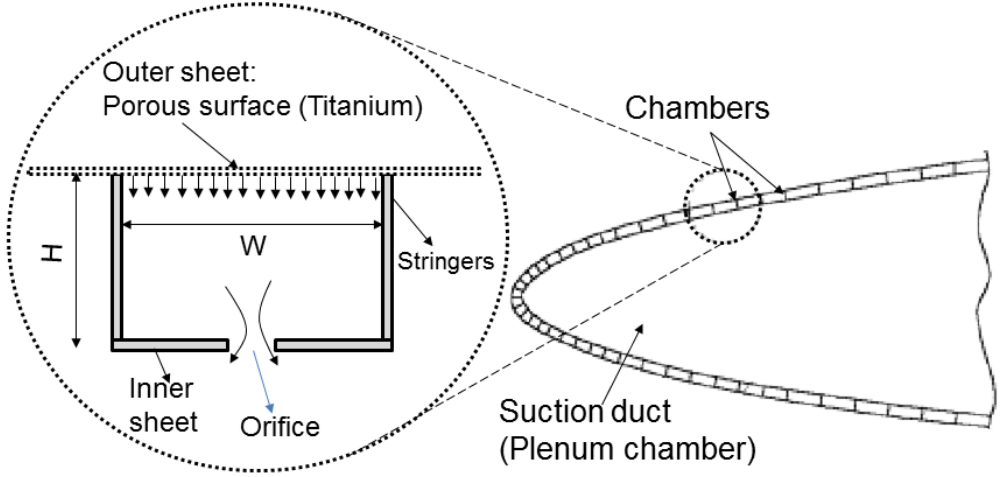
Figure 3. Chamber layout based on ALTTA concept [6] .